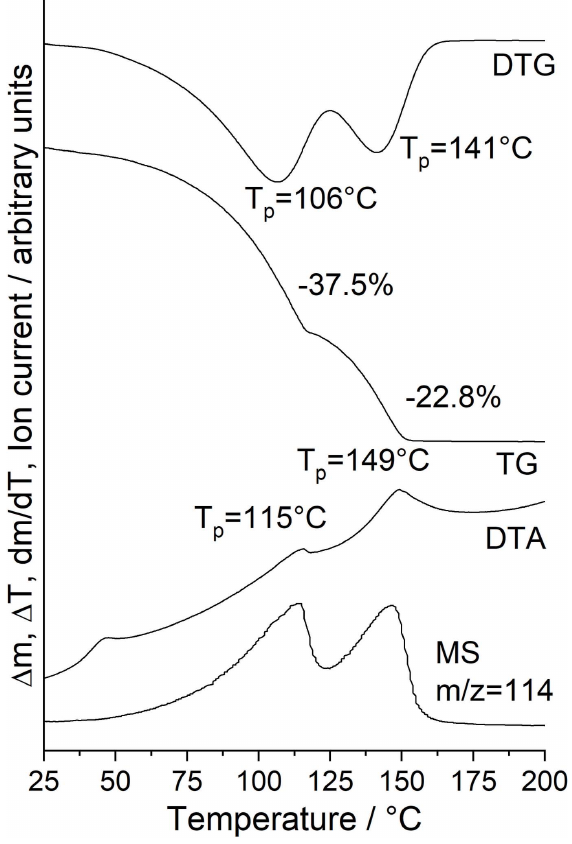
Figure 2 Crystal structure of the title compound in a view along the crystal- lographic a -axis.